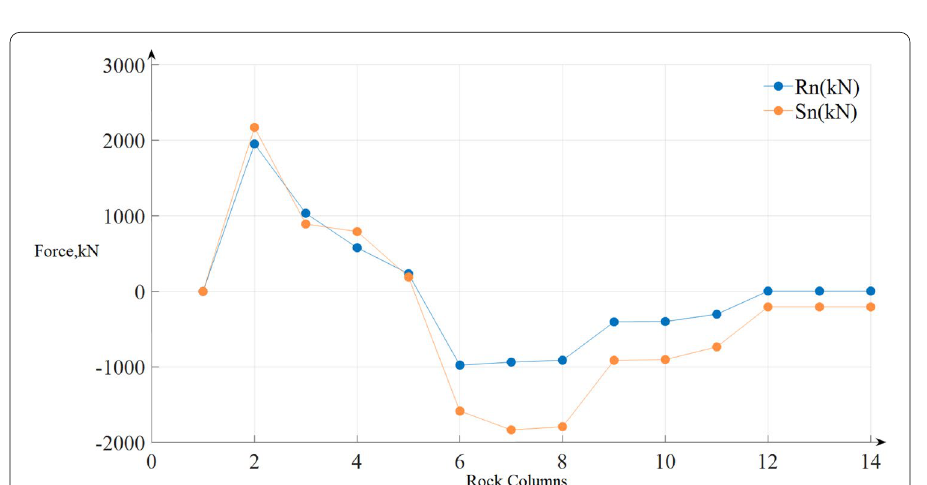
Fig. 10 Distribution of normal (R) and shear (S) forces on the bases of blocks under the influence of